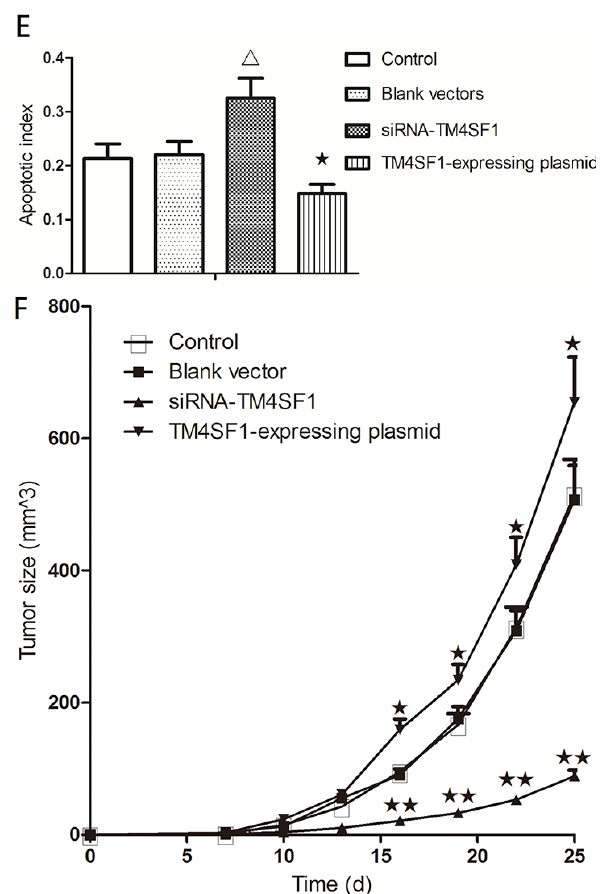
Figure 4. TM4SF1 regulates tumor growth in vivo by modulating cell apoptosis. HepG2 cells